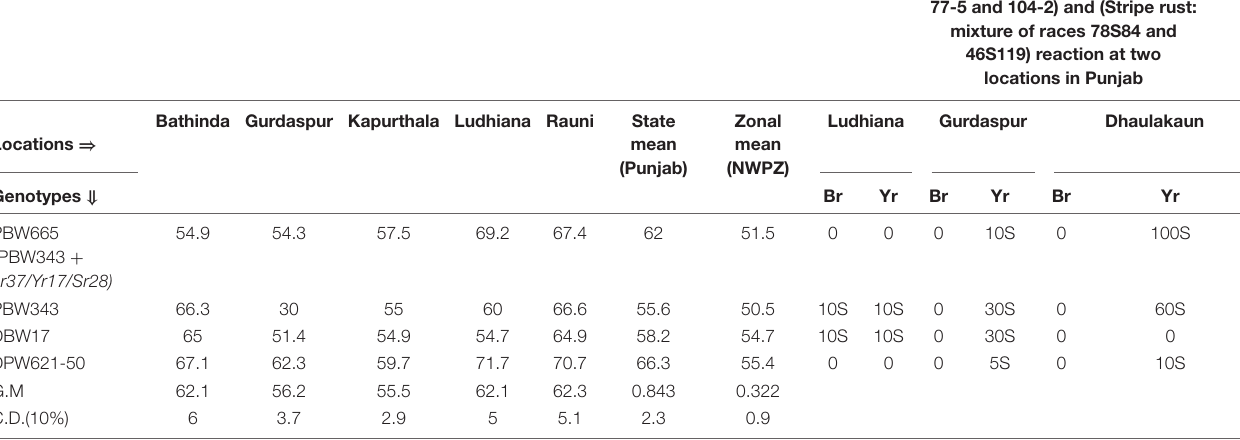
TABLE 2 | Yield performance and rust score of PBW665 in AVT at different locations across Punjab during 2011–2012. Yield performance (quintals/hectare) at five locations in Punjab Rust (Leaf rust: mixture of races